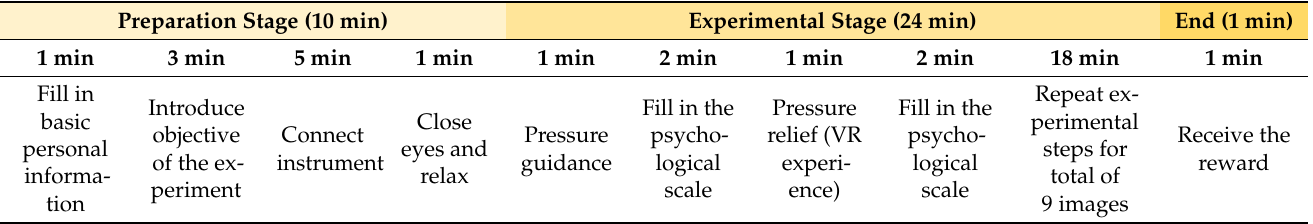
Table 2. Procedure of study B. (The procedure includes three stages: The first stage is for preparation; the second stage is experiment conduction, the final stage is the end. The whole process needs 35